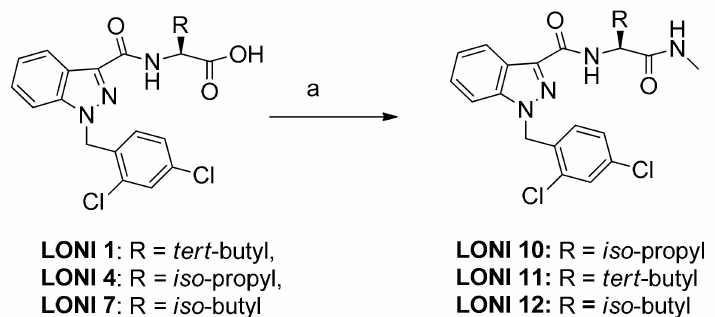
Scheme 3. Reagents and Conditions: ( a ) EDC · HCl (1.1 eq.), HOBt an. (1.1. eq.), NMM (3 eq.),